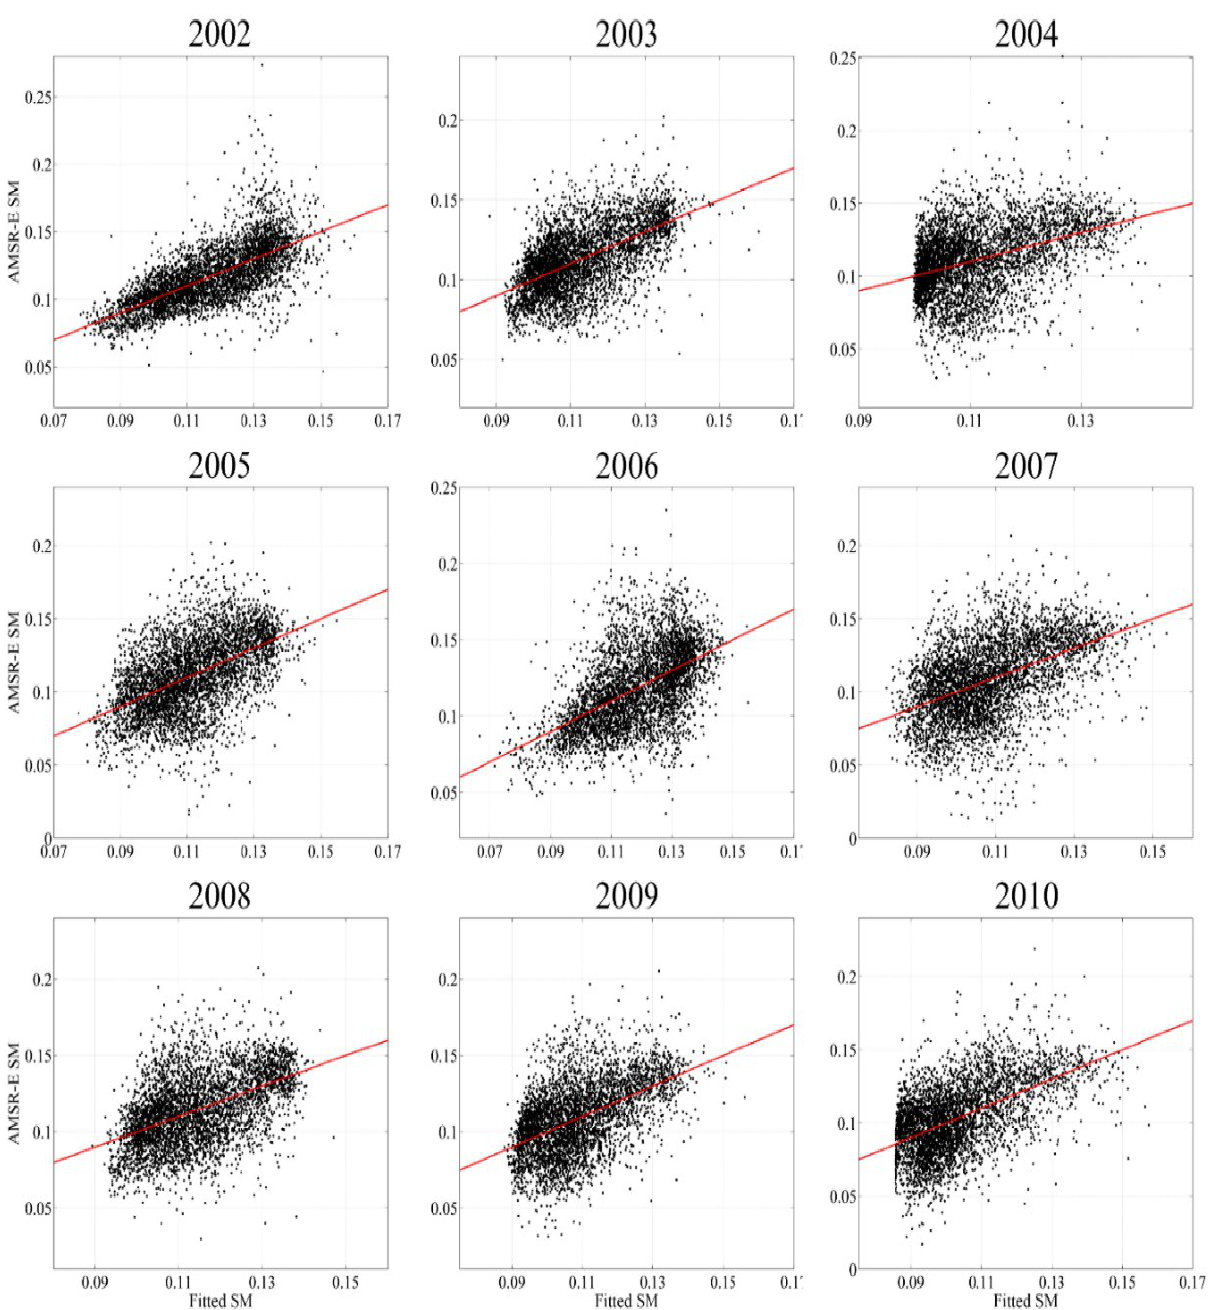
Figure 7. The scatterplots of the fitted SM versus the AMSR-E SM in August 2002–2010 in grassland regions and barren or sparsely vegetated regions of the contiguous